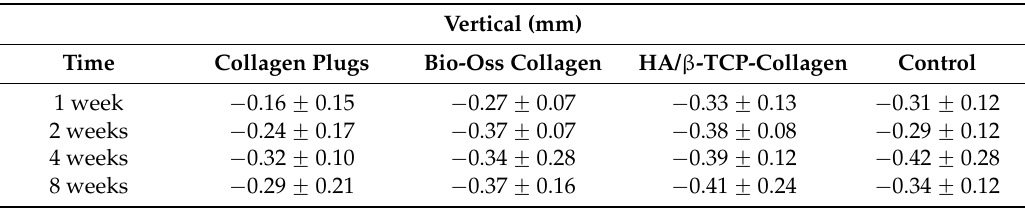
Table 2. Vertical dimensional changes after tooth extraction. Vertical dimensional changes (in